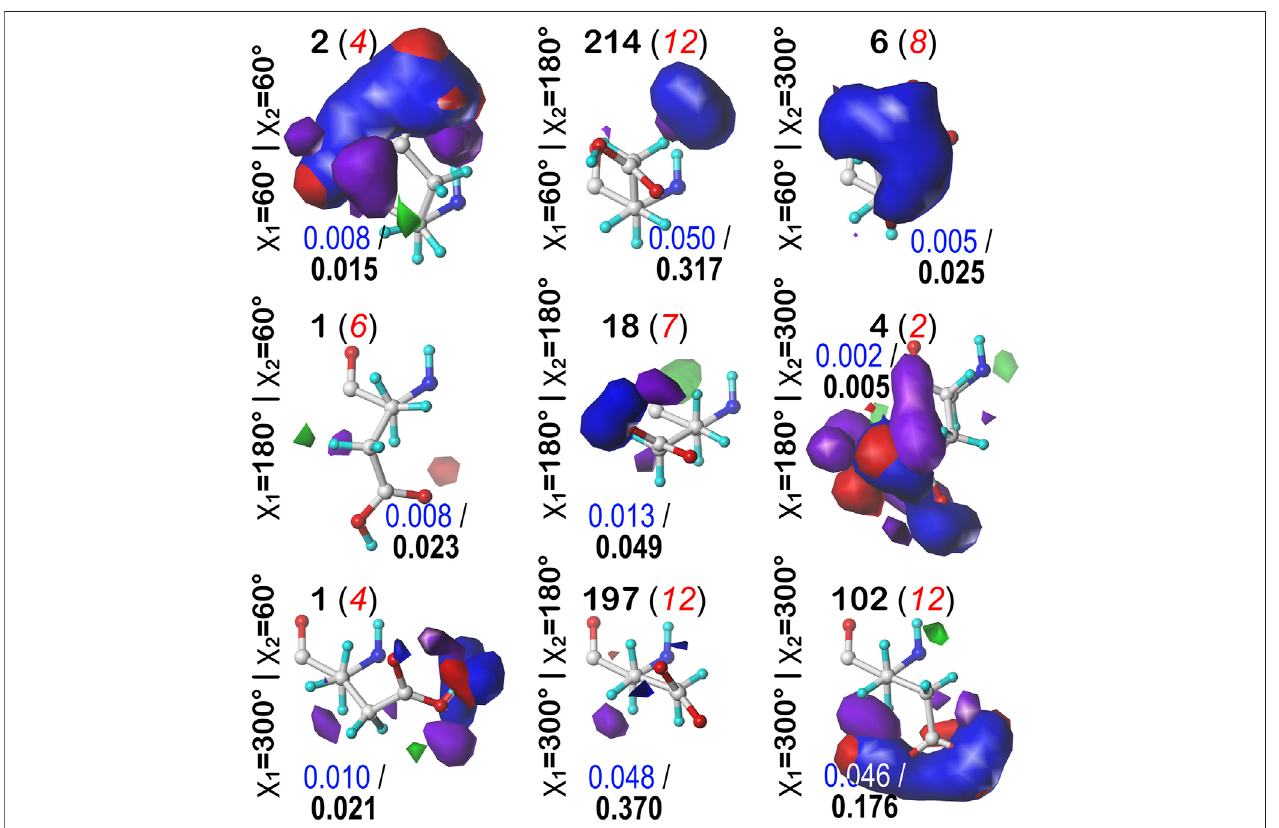
FIGURE10| HydropathicinteractionmapsdisplayingtheGaussian-weightedaveragesidechainenvironmentsofglutamicacidinthehighestpopulatedclustersof thenineparsesofthe b1 chesssquareatpH (cid:1) 4.224.ResiduesareorientedsuchthattheCA-CBz-axispointsupwardandthex-axisrunstotheright.Theparsesofthe χ χ 1 and 2 angles are indicated along the side of each map. The cluster ID and number of clusters in the parse are given above the map in black and red, respectively. Beloweachmap,inblue,isindicatedthefractionoftheentirechesssquarerepresentedbyeachmap,followedinblackbytheparse ’ srepresentativefractionofthe chesssquare.Bluecontoursindicatepositionandmagnitudeofpositivepolarinteractionsnearthesidechain,whileredrepresentsnegativepolarinteractions.Greenand purple contours indicate positive and negative hydrophobic interactions, respectively.